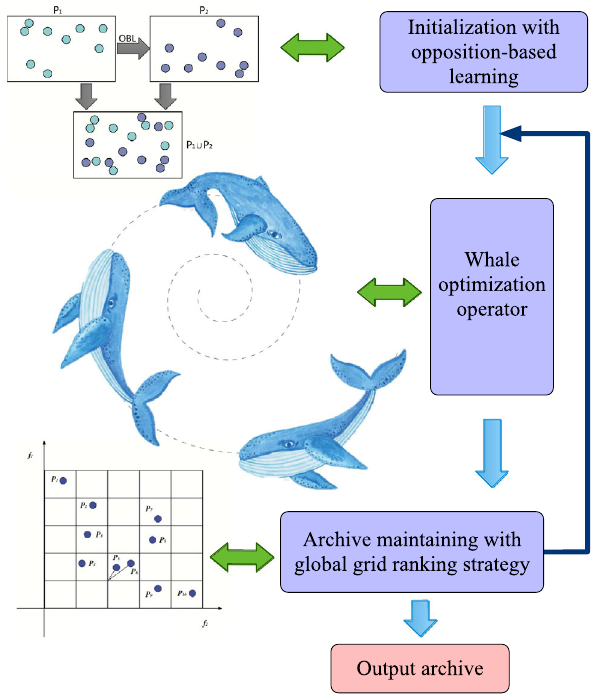
Fig. 5 The diagram of the main mechanism of